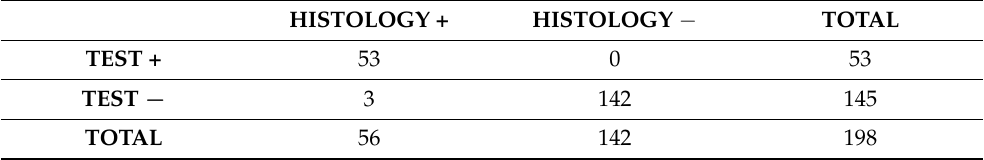
Table 4. The results of the iNatal duo test in patients taking PPI compared with histology. HISTOLOGY